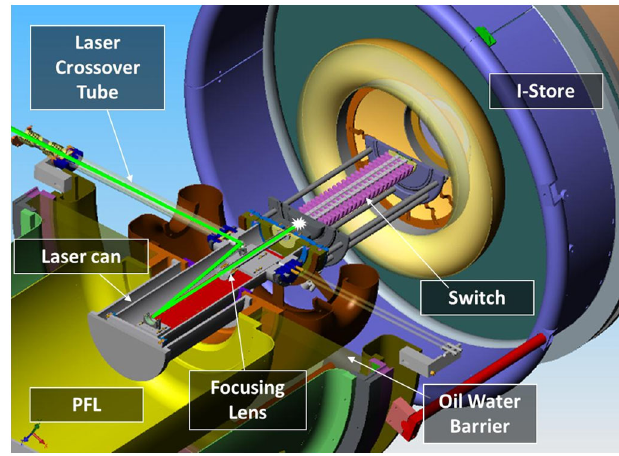
FIG. 2. View of the laser triggered gas switch. A UV beam is used to generate a plasma spark in the switch trigger section which will trigger the switch and conduct the current from the intermediate store (I-store) to the pulse forming line (PFL).